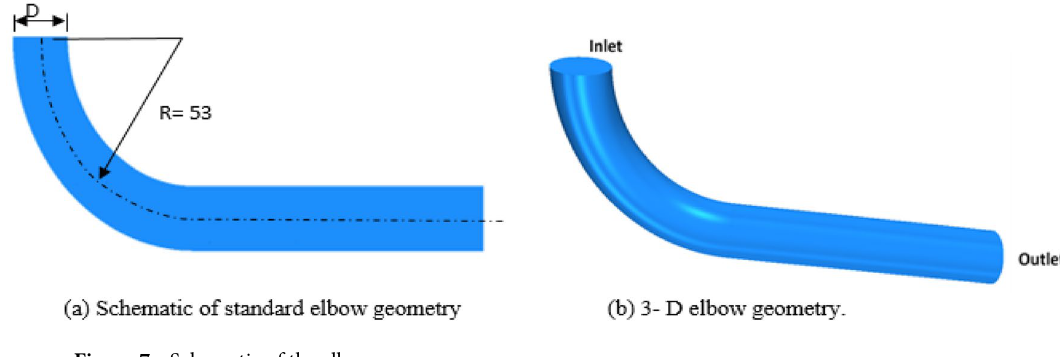
Figure 7. Schematic of the